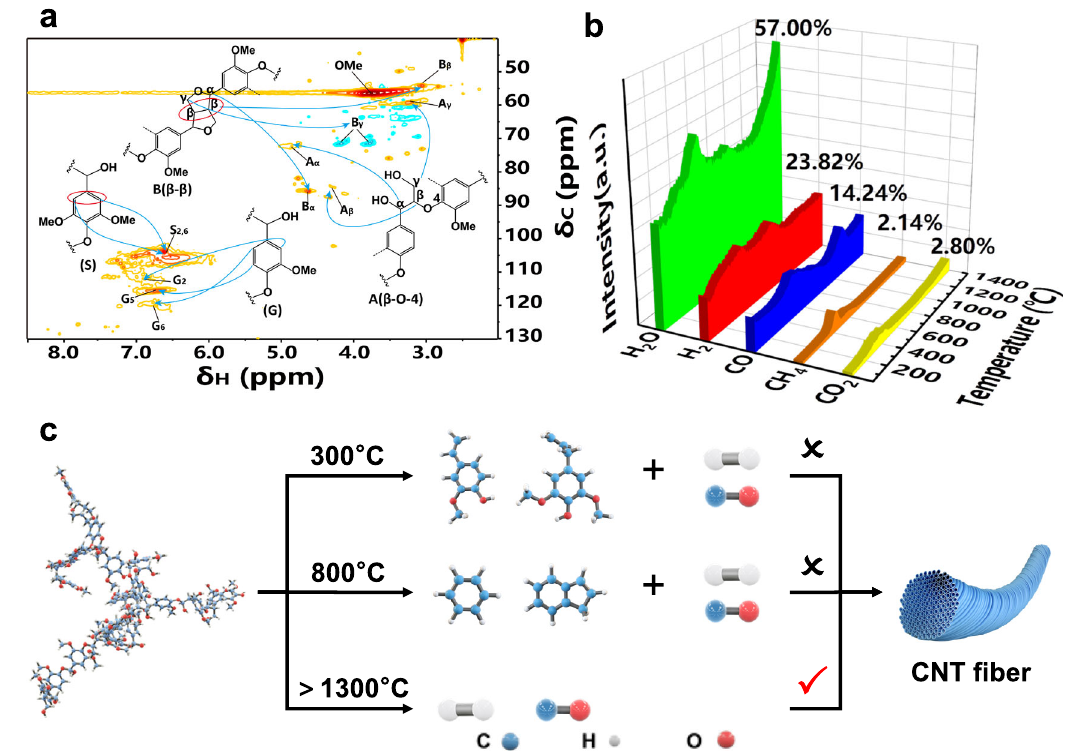
Fig. 2 | Pyrolysis of lignin and synthesis conditions of CNT fi bers. a 2D NMR HSQC spectra (in DMSO-d6) of lignin. b Content of main products obtained from